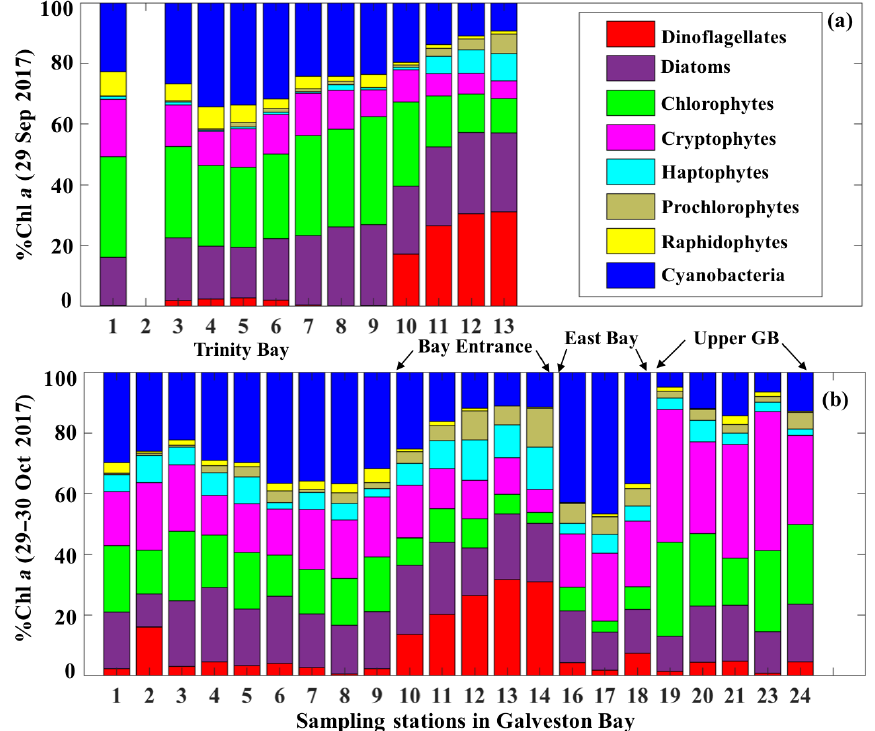
Figure 6. Phytoplankton taxonomic compositions detected from IOP inversion algorithm on (a) 29 September and (b) 29–30 October 2017 in Galveston Bay; phytoplankton groups are represented in different colors as shown in the